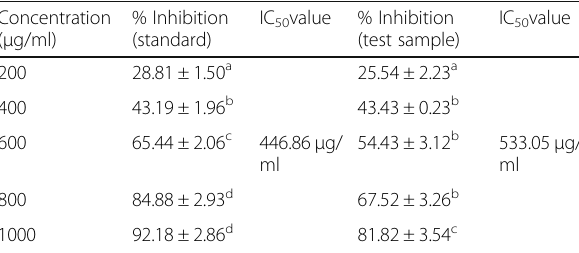
Table 3 Glucose Uptake Enhancement Activity of Chromolaena